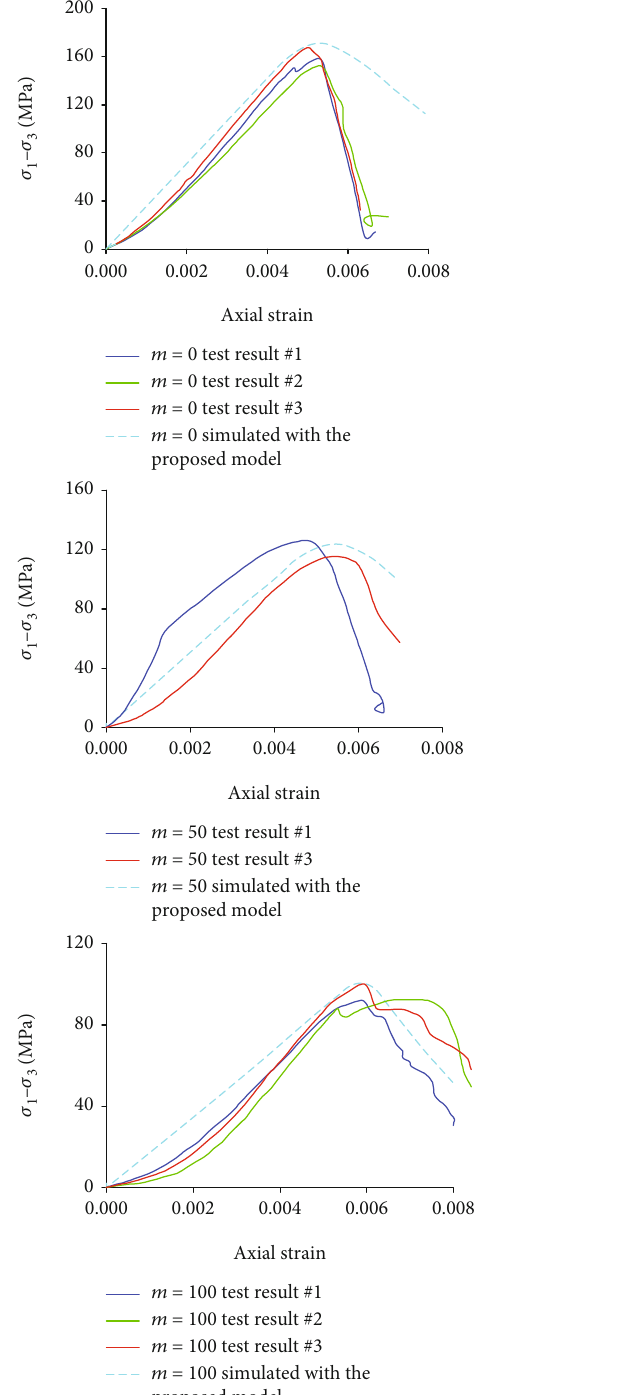
Figure 9: Comparison of the stress-strain relationships for triaxial compression tests with con fi ning pressure σ 3 = 10 MPa by Tan et al. [36] and simulated with the proposed model. The predicted stress-strain relationships agree well with the tested